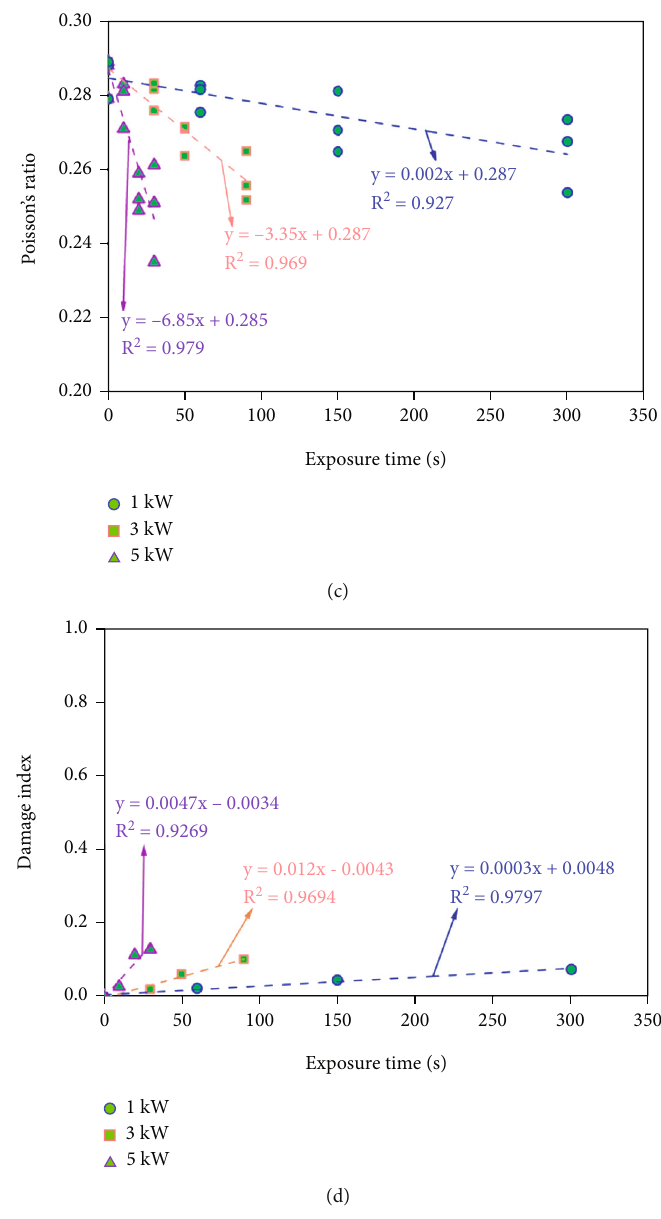
Figure 9: Variation of mechanical constants: (a) elastic modulus of the basalts, (b) damage index based on the elastic modulus, (c) Poisson ’ s ratio of the basalts, and (d) damage index based on the Poisson ’ s